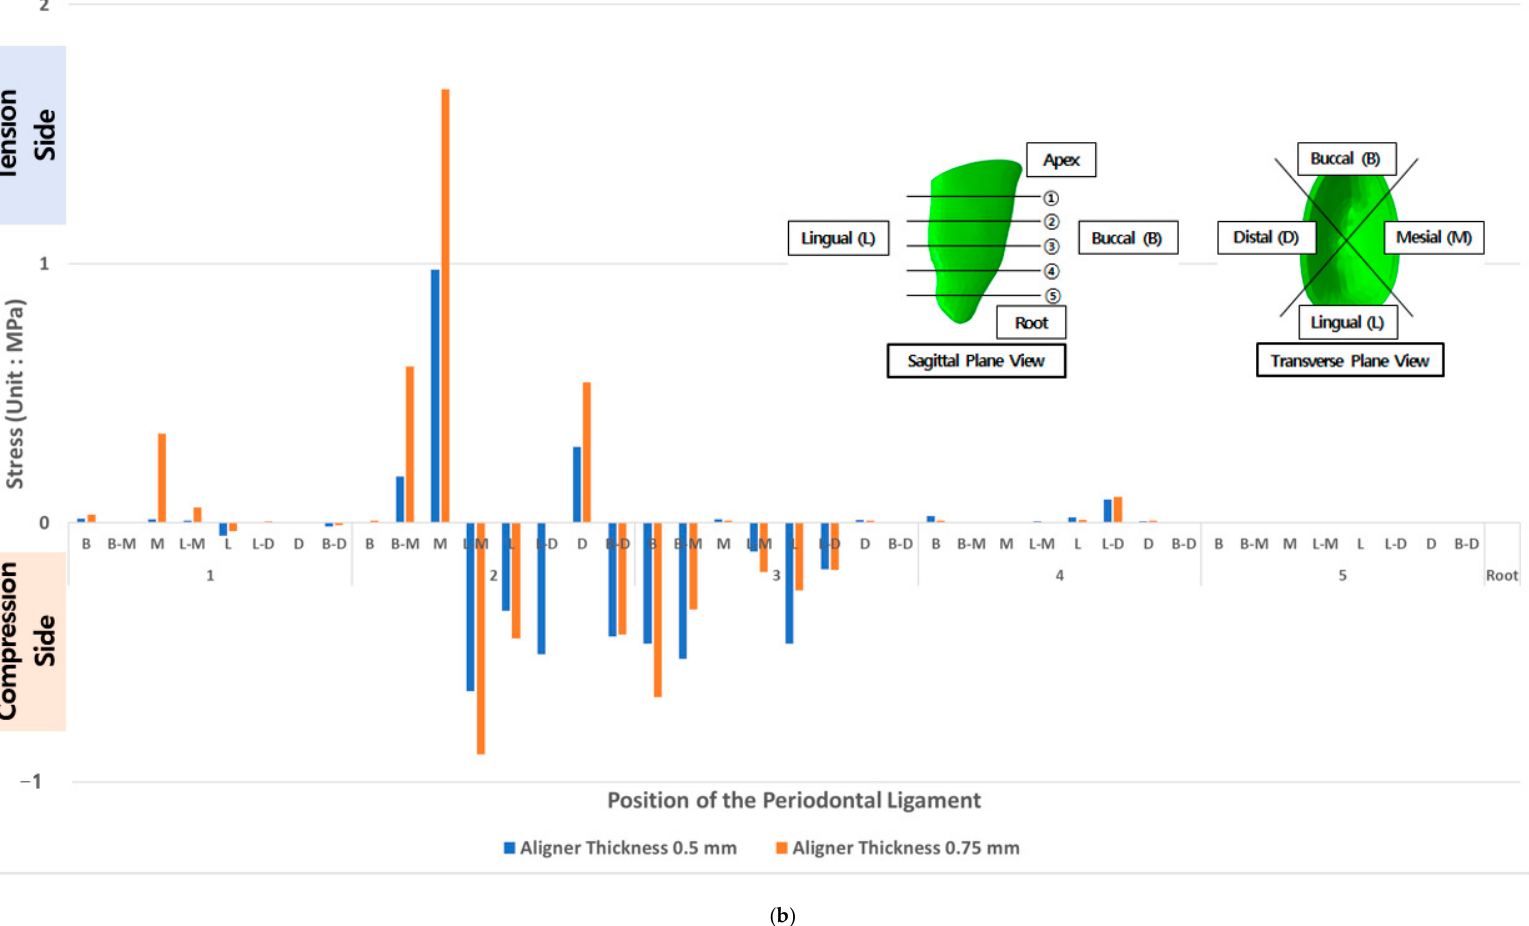
Figure 8. Principal stress in the PDL of the central incisor following aligner treatment procedure. ( a ) Lingual inclination and ( b ) axial rotation correction.